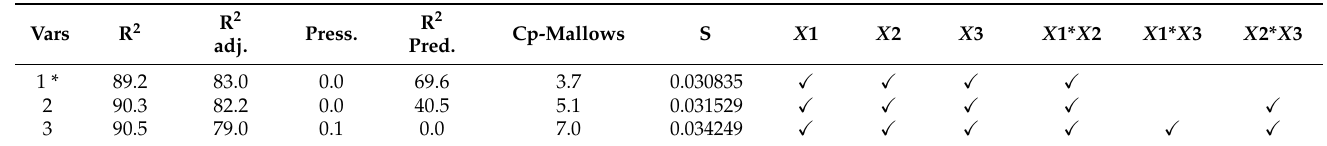
Table 6. Results of best-subset analysis search from MINITAB© for Y 2, comparing the prior model augmented with two ways interactions. Selected choice marked with “*”.